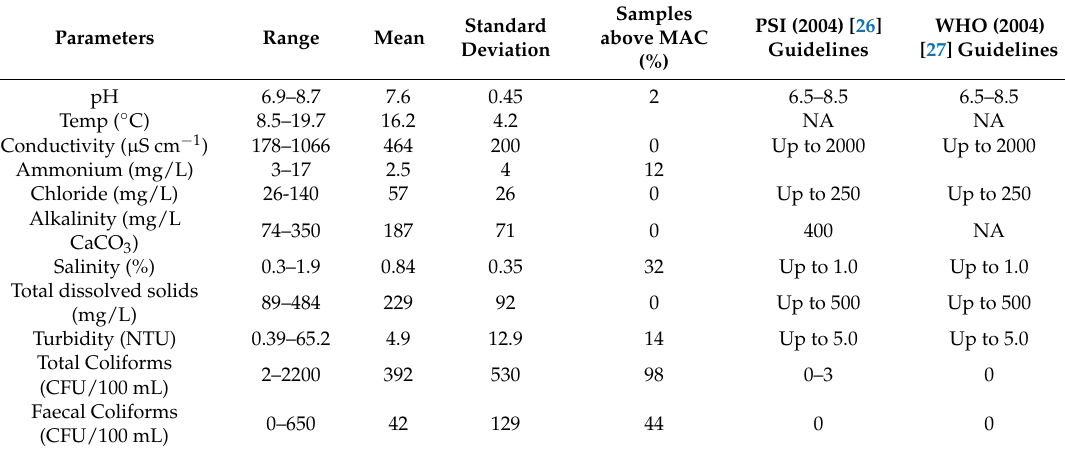
Table 4. Physical, chemical and microbiological characteristics of the mixed